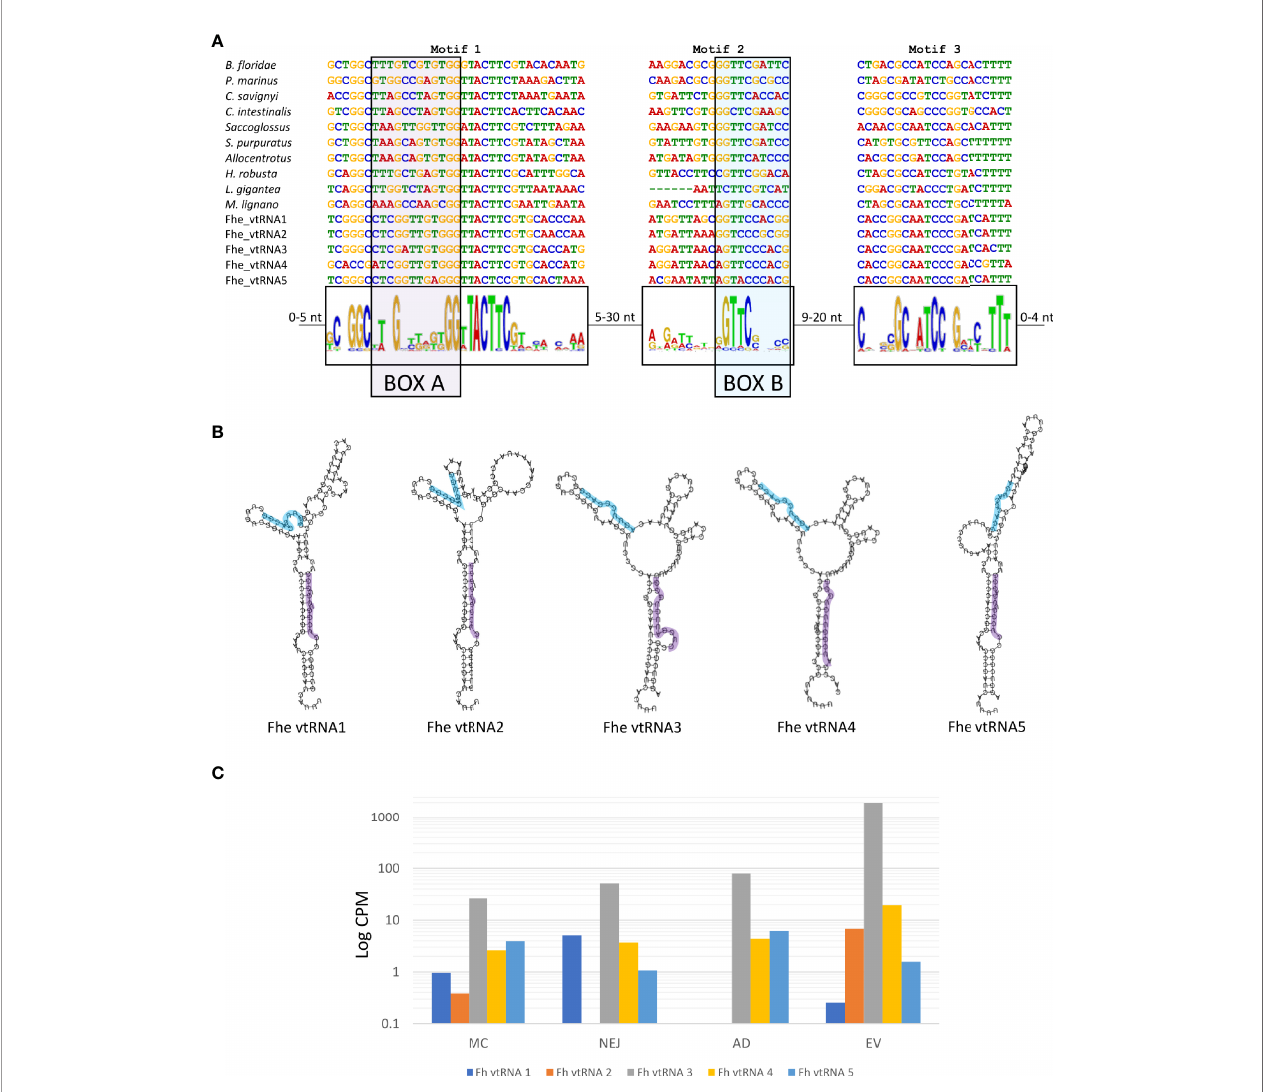
FIGURE 8 | Structure and expression of vtRNAs detected in the genome of F. hepatica. (A) F. hepatica vtRNAs were compared with vtRNAs detected in other species; chordata: Petromyzon marinus , Branchiostoma fl oridae , Ciona intestinalis and C . savigni ; hemichordate: Saccoglosus; Echinodermata, Strongilocentrotus purpuratus and Allocentrotus; Annelida: Helobdella robusta ; Mollusca: Lottia gigantea ; Platyhelminthes: Macrostomum lignano . Motifs 1 and 3 were detected with MEME suite, motif 2 was inferred from the sequence alignment. Motif 1 and motif 2 contain the internal promoter sites of RNA polymerase III [indicated as BOX A (highlighted in purple) and BOX B (highlighted in light blue)]. The sequence range in the variable region between the motifs are indicated. (B) Fhe-vtRNAs panhandle- like secondary structure, Box A is highlighted. (C) Bar chart with the expression pro fi le of fhe vtRNAs in the stages analyzed. Reads were averaged between samples, normalized to count per million and a logarithmic scale was applied to improve data